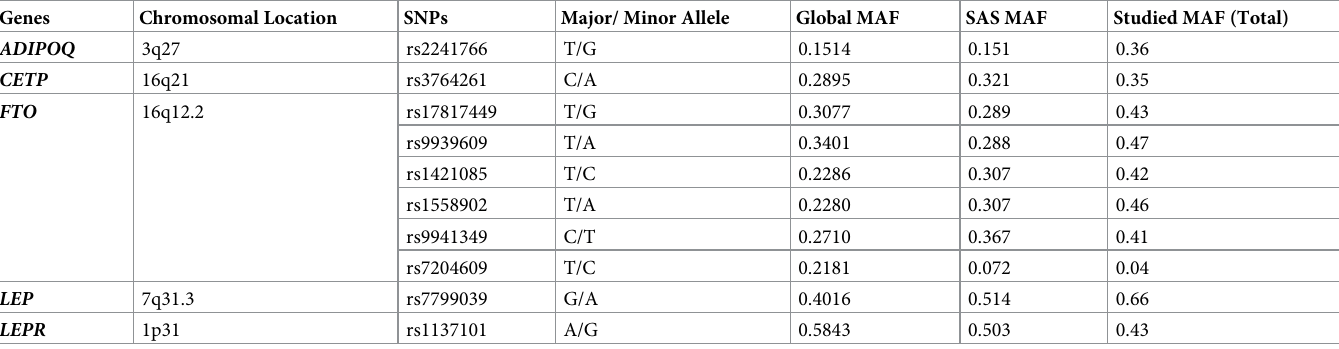
Table 2. Details of genetic variants and MAFs in global, SAS and studied population.